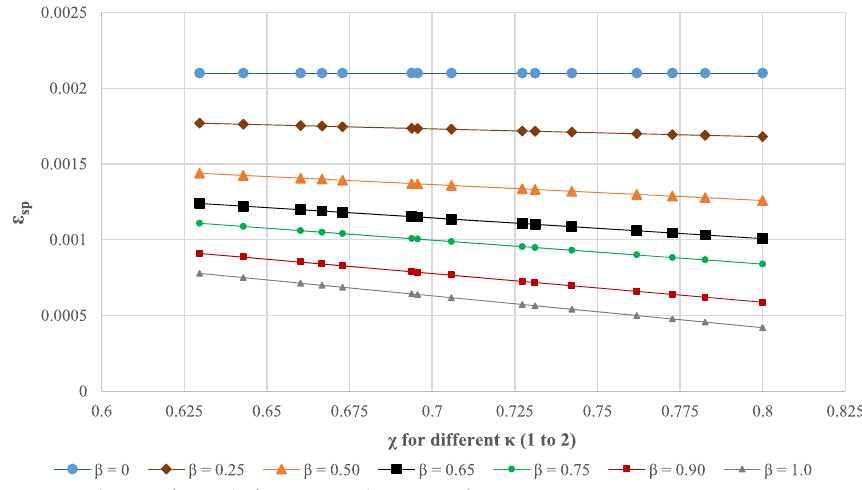
Fig. 21 Evaluation of ε sp and χ for corresponding κ at ε y of